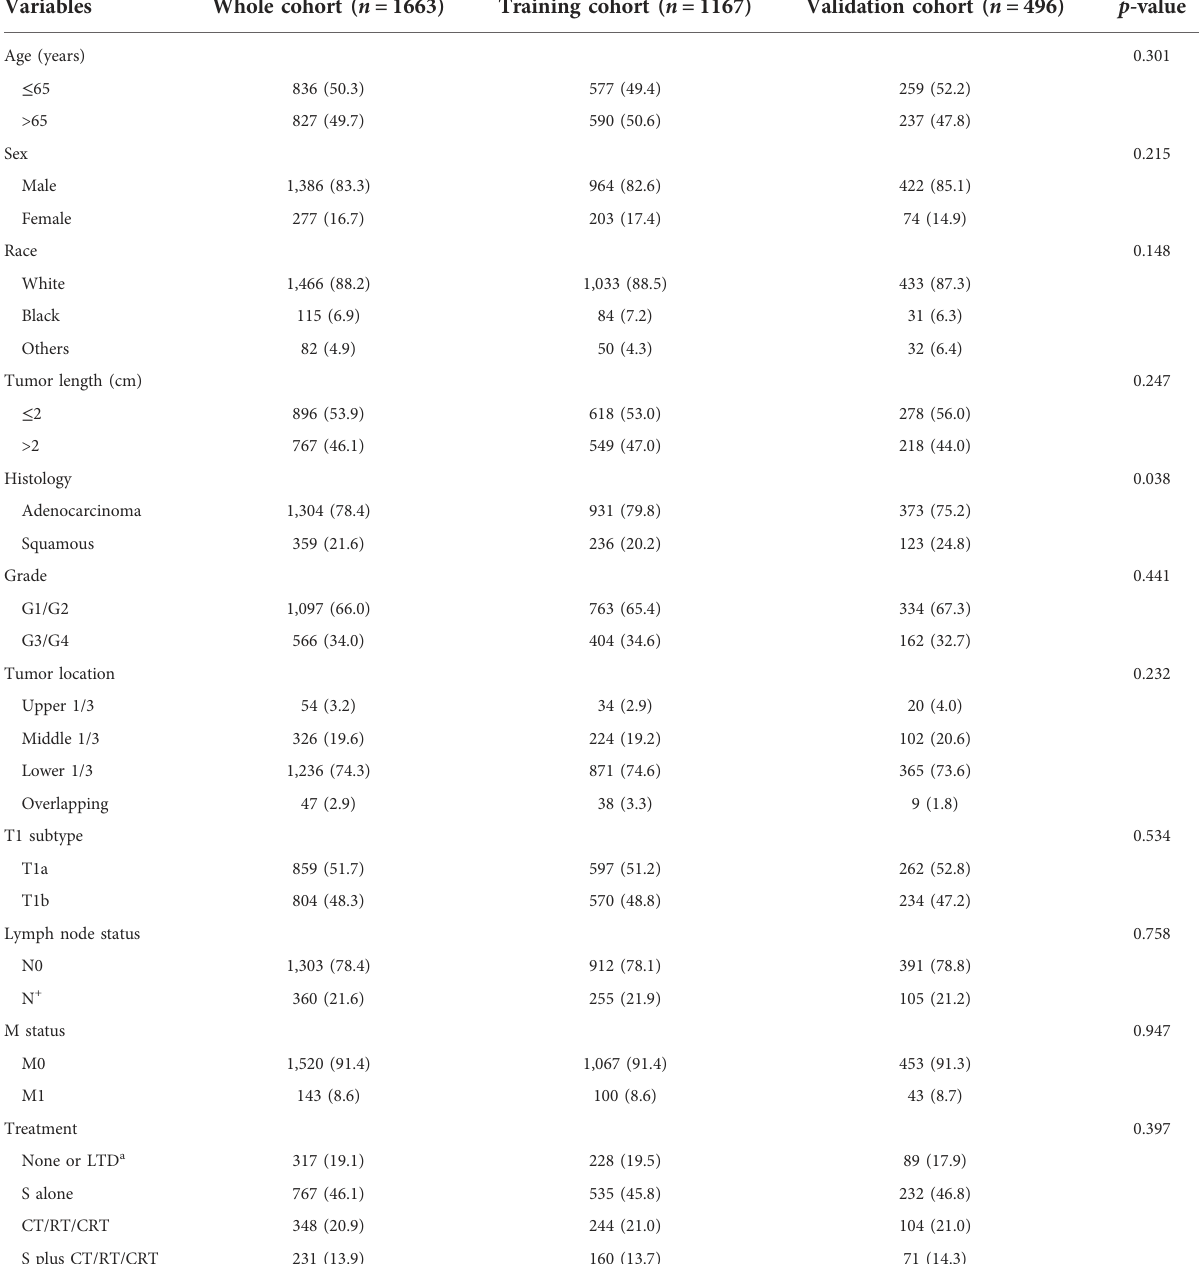
TABLE 1 Clinicopathologic characteristics of T1 EC